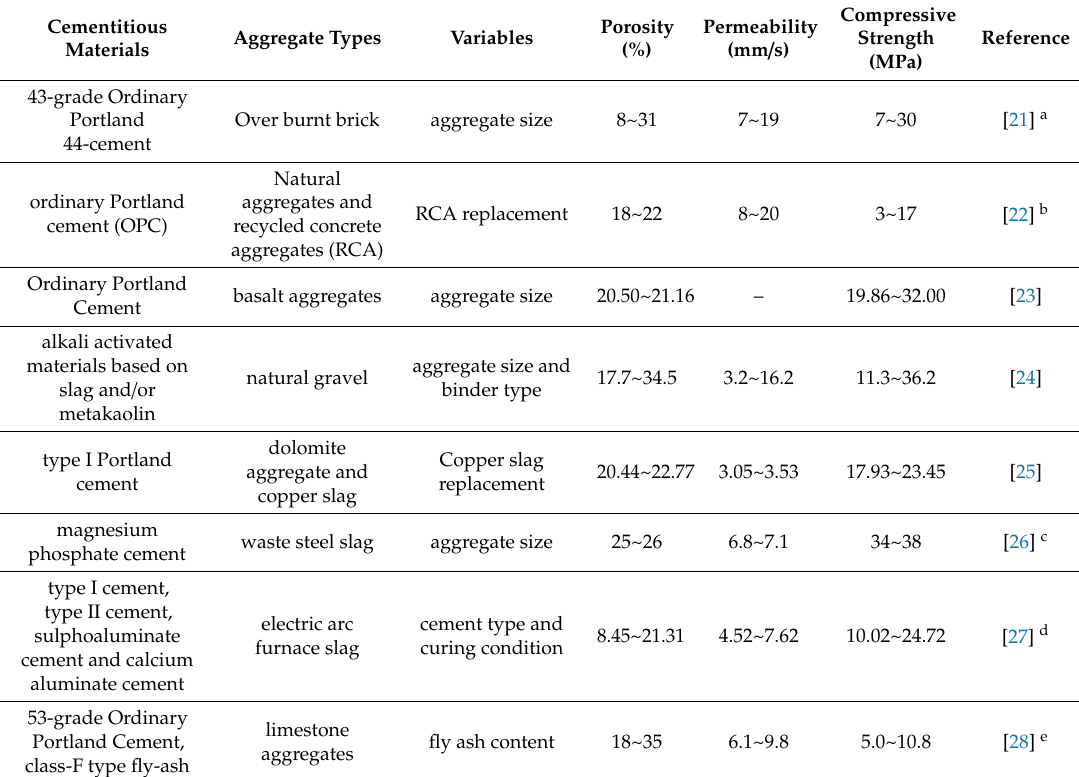
Table 1. Summary of the variables and properties of pervious